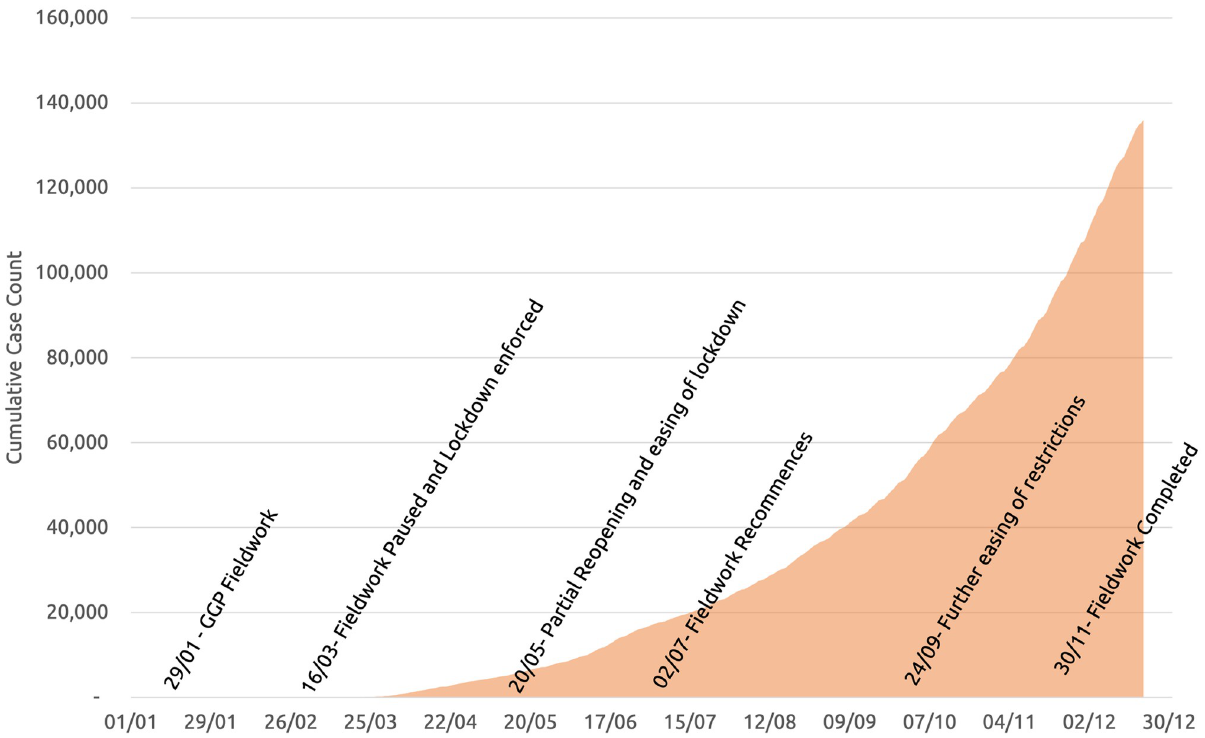
Fig 2. Cumulative cases of COVID-19 and timeline of events [16]; Authors’ own vizualization and annotations.